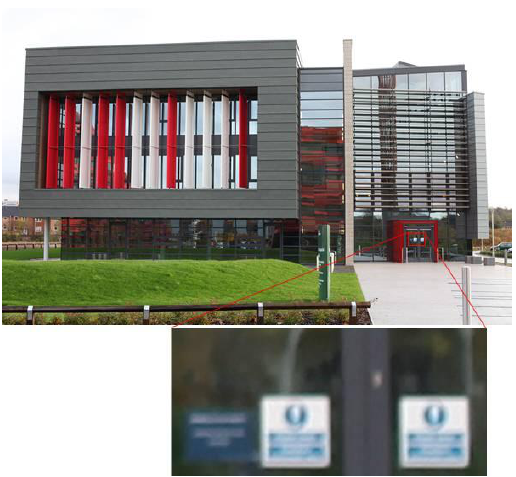
Figure 7. iPad 2 network of images used for 3D building modelling